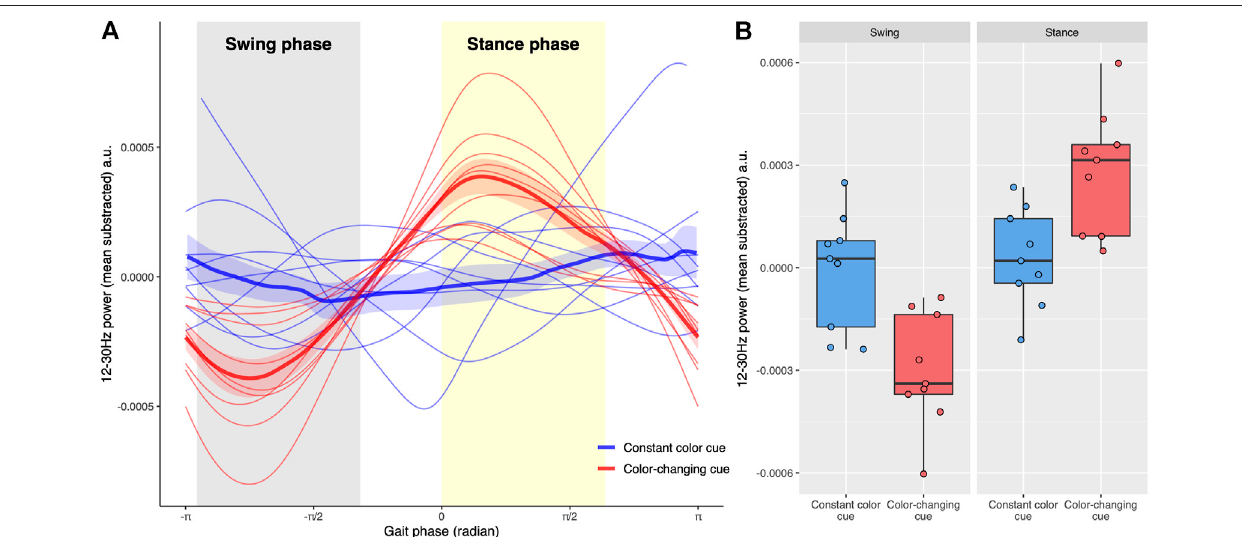
FIGURE3|(A) Therelationshipbetweentotalbeta-power(12 – 30 Hz)andgaitphases.The swingphase oftherightleg(grayshadedarea)isfrom-0.90 π to-0.34 π radianswhilethestancephase(yellowshadedarea)oftherightlegisbetween0and0.60 π radians.Thegaitphasewasdeterminedincludingallstridesineachtrial.Trials with constant color cues are blue, whereas trials with color-changing cues are red. The thick lines represent the average power across trials and the associated shaded regionshows the standard errorofthe mean acrosstrials. (B) Boxplots show totalbeta-power inswing and stance phases for twotypes ofvisual cues. Each point represents theaverage power ofeach trialineach phase. Trials with constant colorcuesare blue whereas trials withcolor-changing cuesare red. The Condition byGait phase interactionforthetotalbeta power wassigni fi cant( p < 0.001),re fl ectingthat thepower ofthecolor-changingcueswaslowerintheswingphase and higher inthe stance phase compared to non-color changing